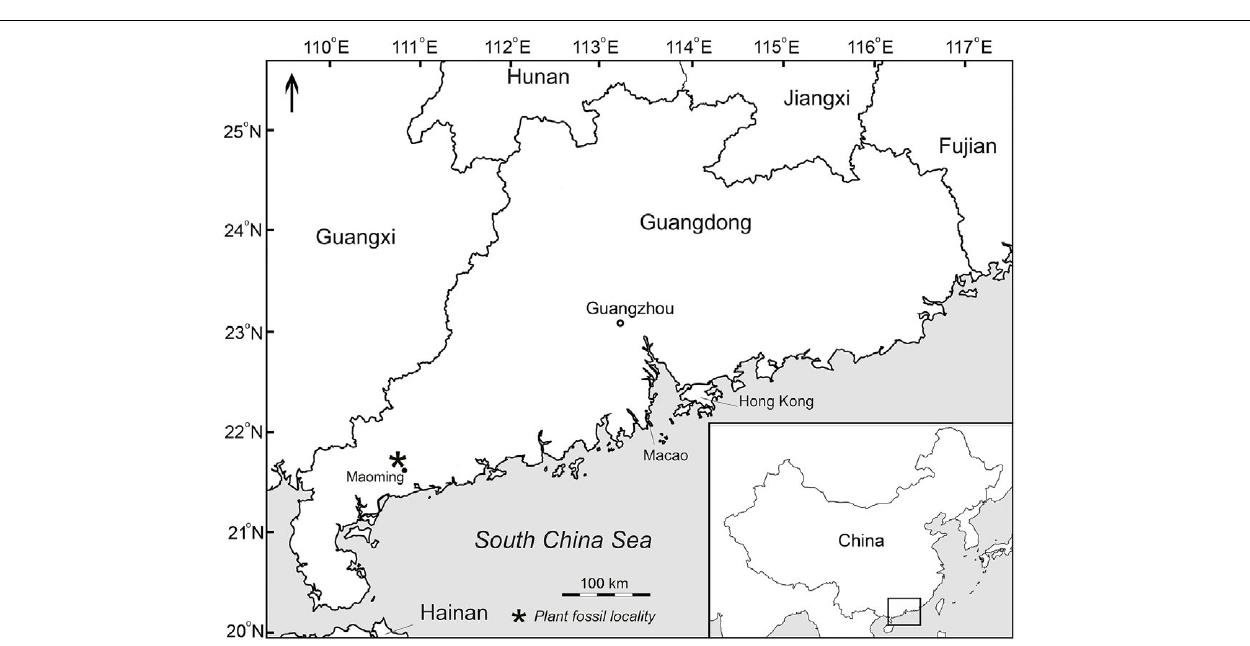
FIGURE 2 | Map showing plant fossil locality (asterisk) in the Maoming Basin, South China.